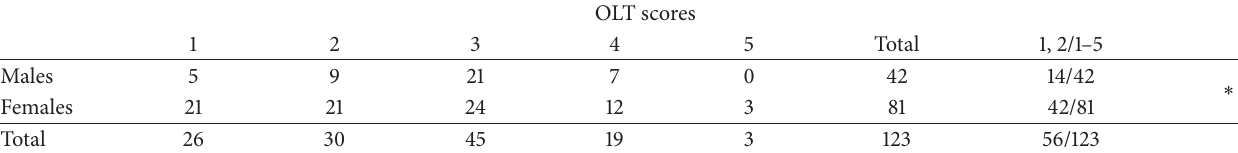
Table 1: The organoleptic test (OLT) results.